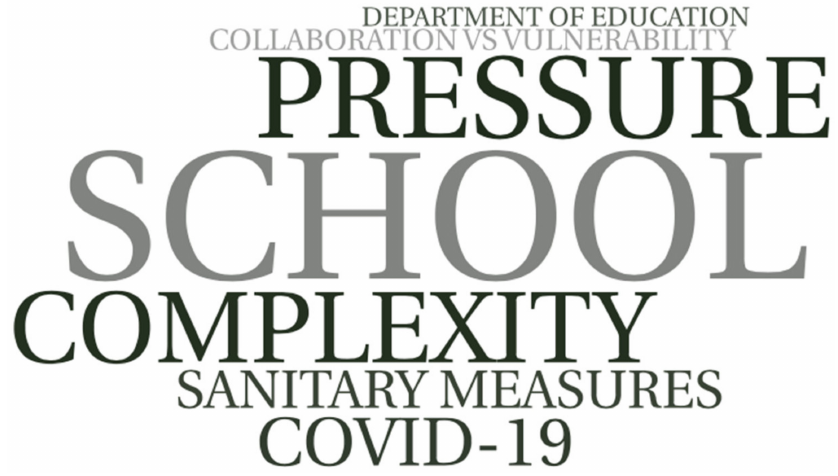
Figure 6. World cloud alluding to arguments in relation to school. Self-made